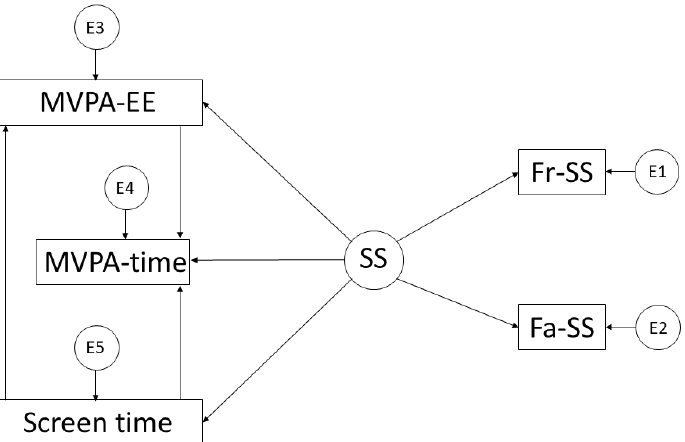
Figure 2. Theoretical model proposed in relation to MVPA. Moderate–Vigorous Physical Activity Time (MVPA-time); Moderate–Vigorous Physical Activity Energy Expenditure (MVPA-EE); Screen Time (ST); Social Support (SS); Support from Friends (Fr-SS); and Support from Family